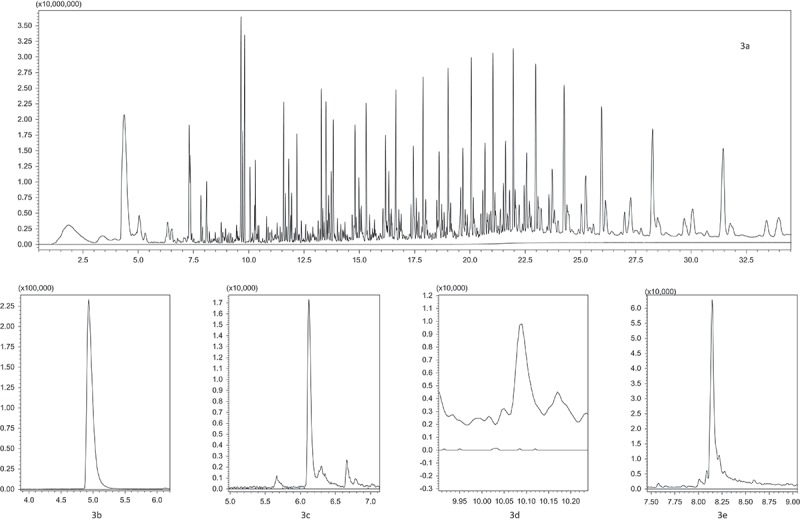
Full-scan pyrogram of sample 4 showing branched aliphatic hydrocarbon distributions from the PP/PE polymer matrix (a; full scan 50–1000 m/z); selected peaks of styrene (b; selected ions 78.0 and 104.1 m/z) and α-methylstyrene (c; selected ions 103.1 and 118.2 m/z) confirming the presence of polystyrene fractions in the sample; peaks of 1-phenyl-1-propene (d; selected ions 54.1/77.0 and 105.1 m/z) and benzoic acid (e; selected ions 77.0/105.1 and 122.1 m/z) prove the presence of PBT or PET traces in the sample. All pyrograms are compared with a sample blank which is represented by each chromatogram at the bottom.